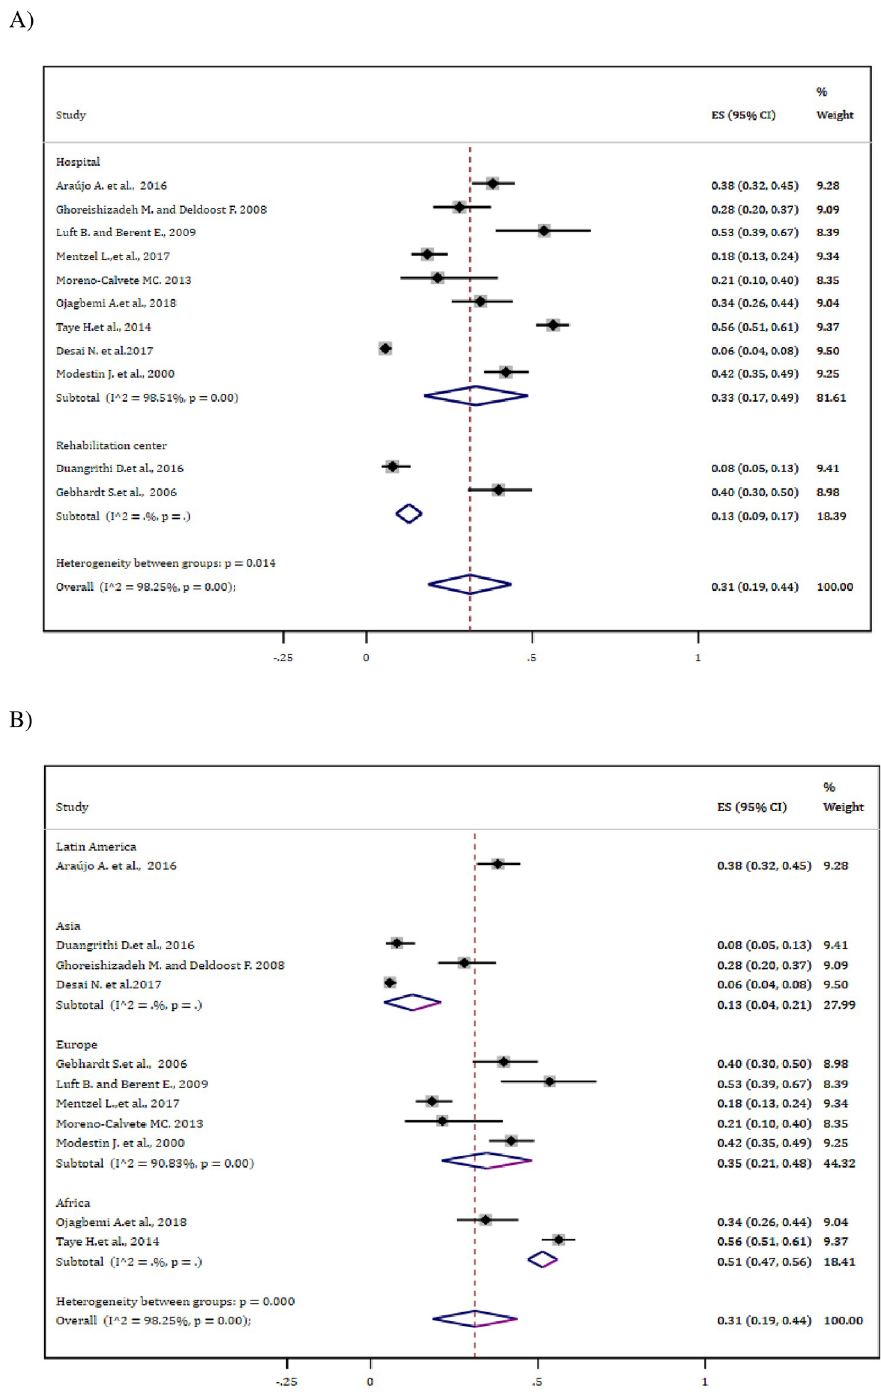
Fig 3. Subgroup analysis of the overall EPSE estimate (A) Based on settings (B) Based on geographical distribution.